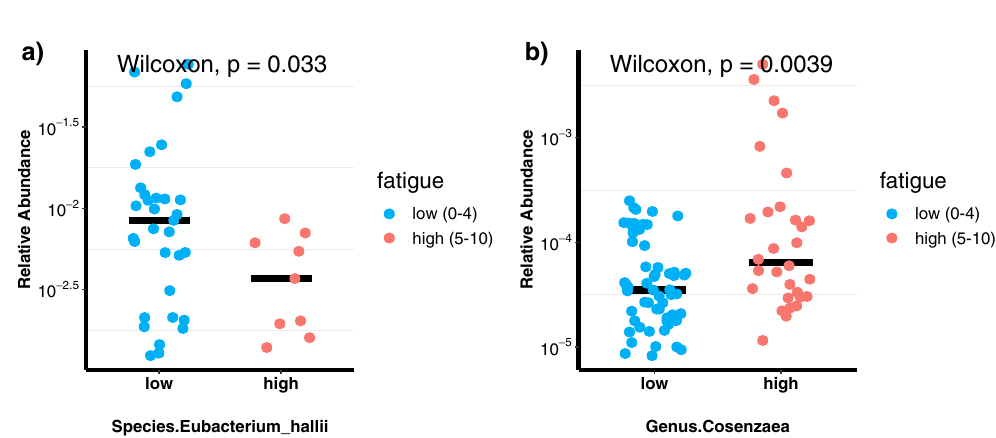
Figure 4. ( a ) Dot plots showing differences in relative abundance in Eubacterium hallii abundance between the high- and low-fatigue groups. Each blue dot represents one patient in the low-fatigue group; each red dot represents one patient in the high-fatigue group. The black bar denotes the median. ( b ) Dot plots showing differences in relative abundance in Cosenzaea abundance between the high- and low-fatigue groups. Each blue dot represents one patient in the low-fatigue group; each red dot represents one patient in the high-fatigue group. The black bar denotes the median. In both figures, we performed log10 transformation of the data so that the data points are evenly distributed. The numbers on the y-axis denotes the original quantity of relative abundance, which are just the scientific format of the abundance